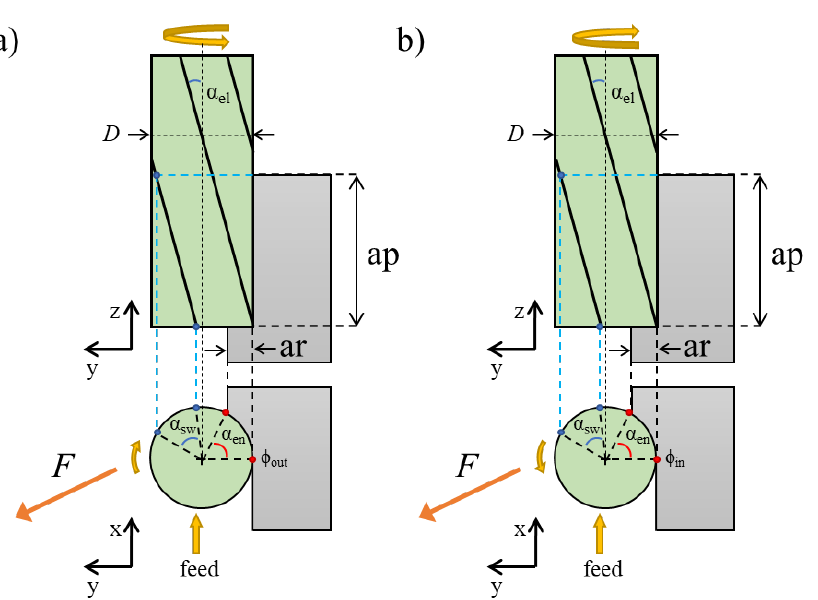
Figure 1. Schematic diagram of milling parameters: ( a ) Down-milling ( b ) Up-milling).